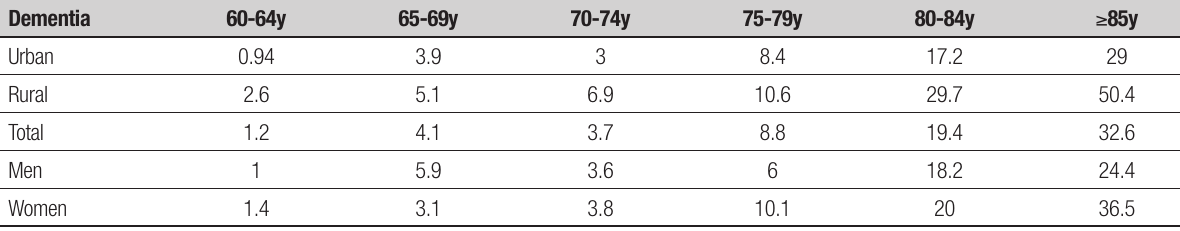
Table 2. Prevalence (%) of dementia by age group, in urban and rural samples and in men and women.